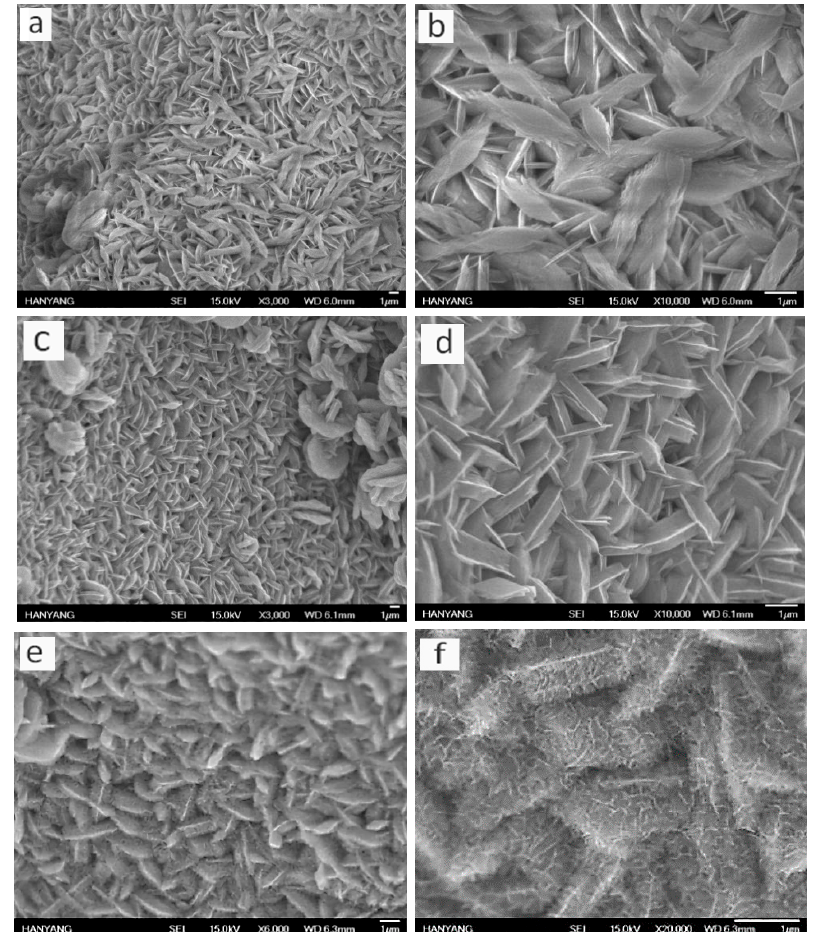
Figure 3. Scanning electron microscope (SEM) images of NiCo-LDH electrode materials at versatile magnifications ( a , b ), NiCo 2 O 4 electrode materials at different magnifications ( c , d ), and NiCo 2 O 4 @NiCo 2 O 4 electrode materials at versatile magnifications ( e , f ).